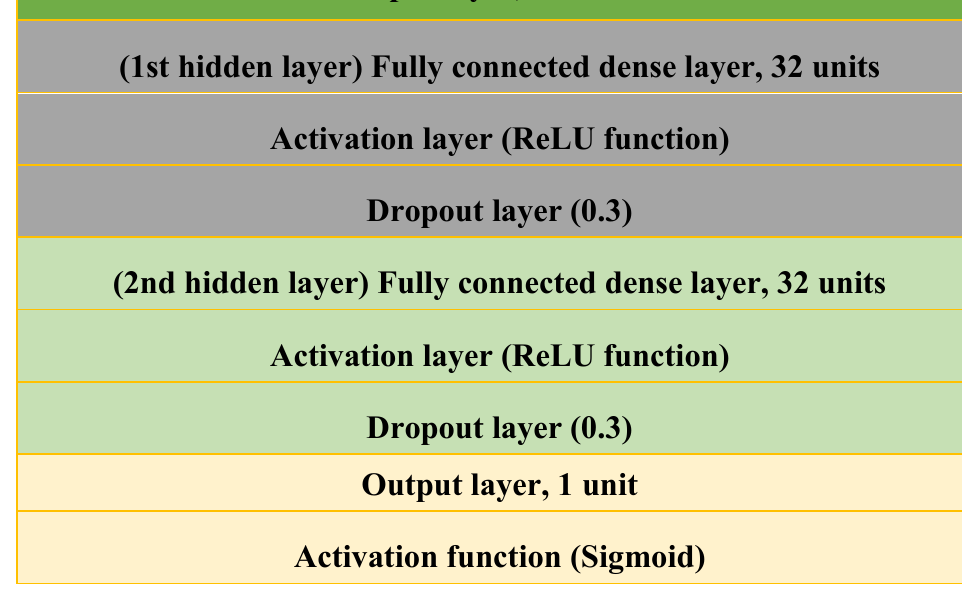
Figure 10. Architecture of the Multilayer Perceptron.